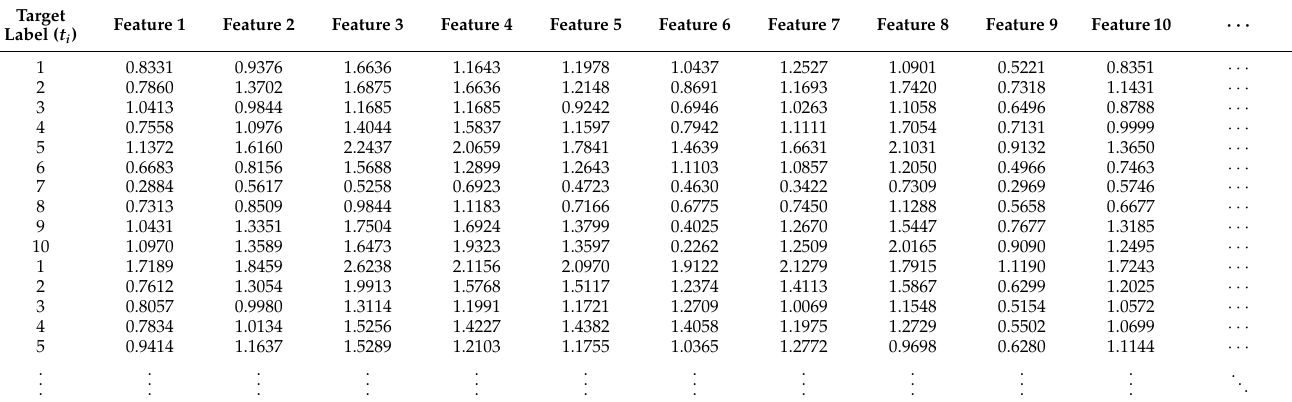
Table 6. Results recovered by Algorithm 2.